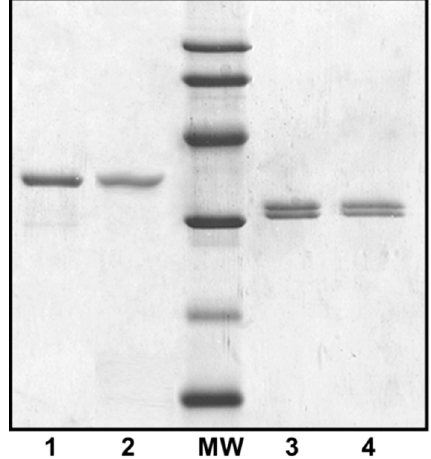
Figure 2. Purified polar and lateral flagellins from several A. hydrophila strains. 1, A. hydrophila AH-1 (wild-type) polar flagellin; 2, A. hydrophila AH-1 ∆ rmlB mutant (no O -antigen LPS produced) polar flagellin; MW = molecular weight standard (14, 20, 30, 45, 60, and 94 kDa); 3, A. hydrophila AH-1 Δ flaB - J (unable to produce polar flagellum) lateral flagellin; and 4, A. hydrophila AH-1 ∆ rmlB mutant lateral flagellin.